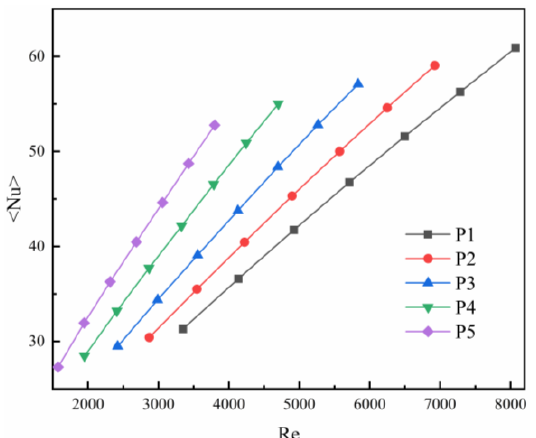
Figure 23. Distributions of average Nusselt number versus different Reynolds numbers and Prandtl numbers.